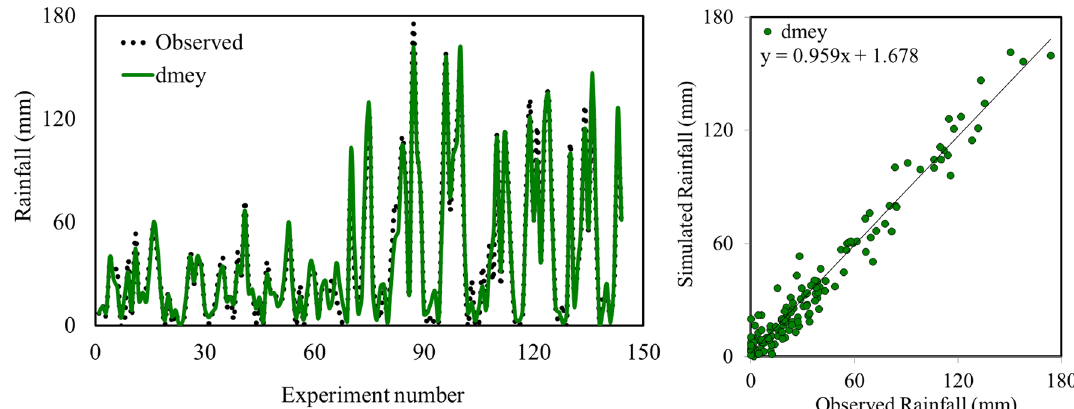
Fig. 6 Comparison of rainfall amounts simulated by mother wavelet dmey and observed values